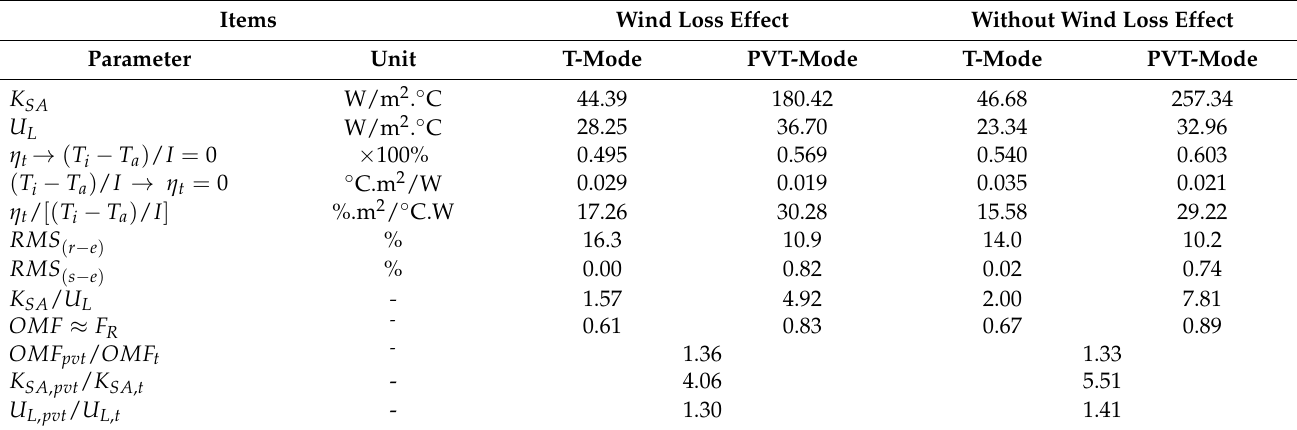
Figure 6. Electrical and thermal efficiency: ( a ) PVT-mode (simulation) wind loss effect and without wind loss effect; ( b ) the effective region for PVT-mode (simulation) vs. T-mode (simulation) for the without wind loss effect.